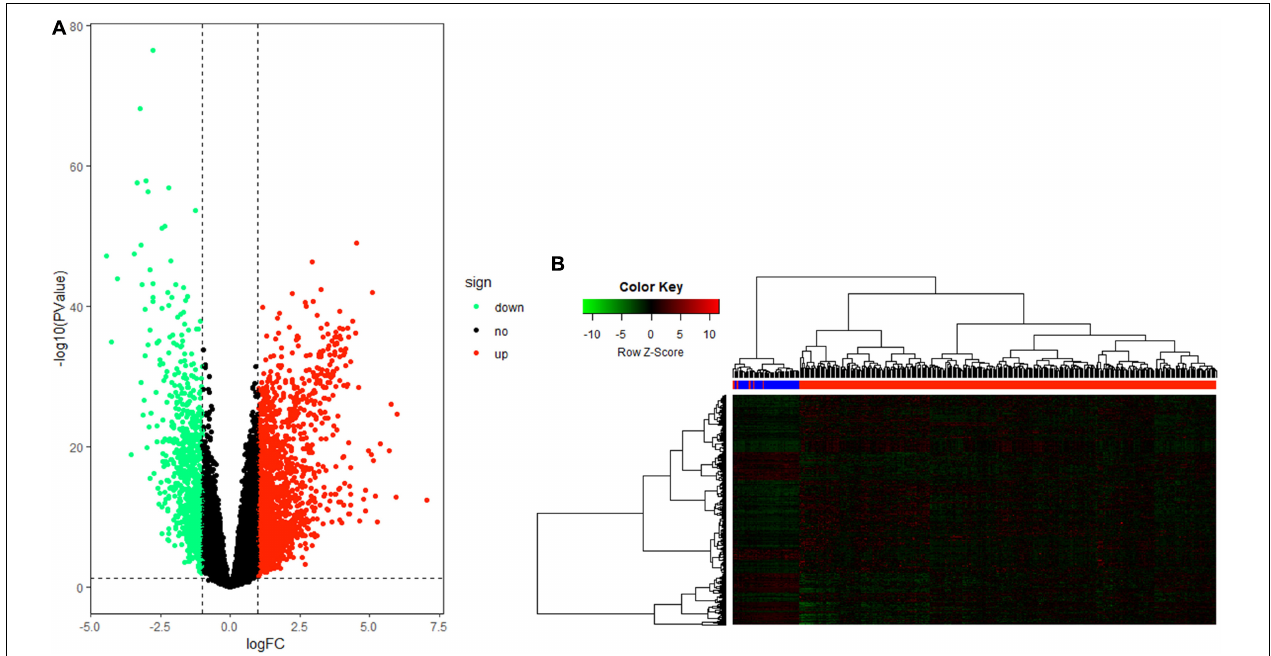
FIGURE 2 | Differentially expressed gene (DEG) identification. (A) Volcano plot of all genes in hepatocellular carcinoma (HCC). (B) Heatmap plot of all DEGs.